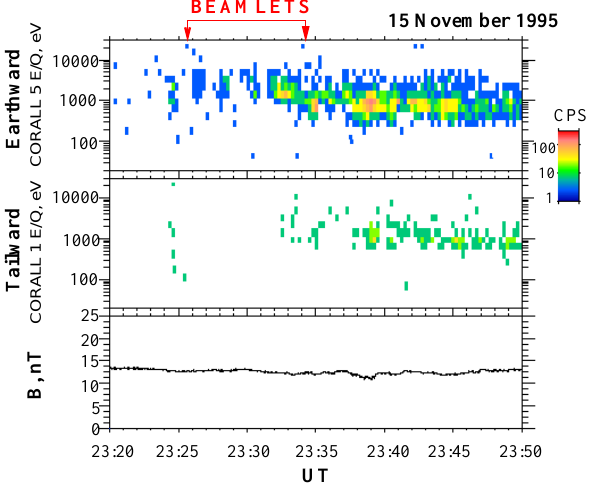
Fig. 3. An example of “attached” beamlet. The figure layout is the same as Fig. 2 except for distribution.